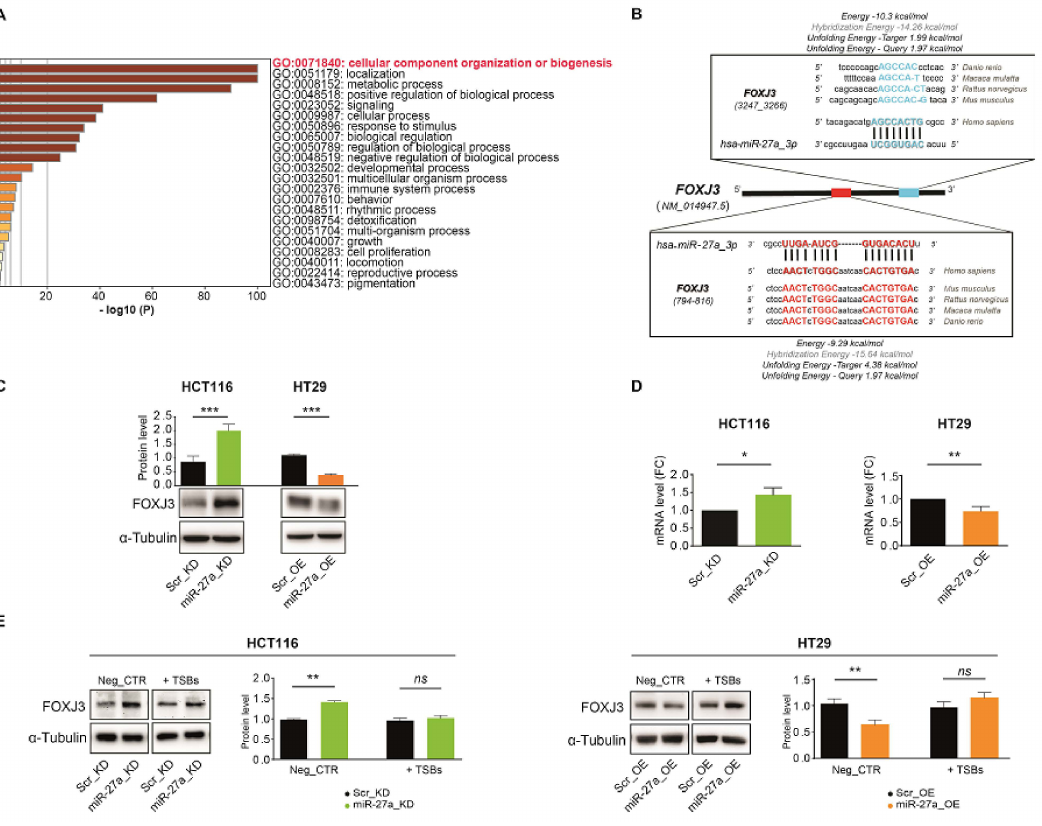
Figure 1. Recognition of the pathways modulated by FOXJ3, identification of the seed sequences for miR-27a on FOXJ3 mRNA, and expression in a CRC cell model system in vitro. ( A ) The bar graph illustrates the top Gene Ontology biological processes, identified via Metascape, using a discrete color scale to represent statistical significance (a deeper color indicates a smaller p -value). ( B ) FOXJ3 mRNA contains two seed sequences for miR-27a-3p. The characteristics of the binding